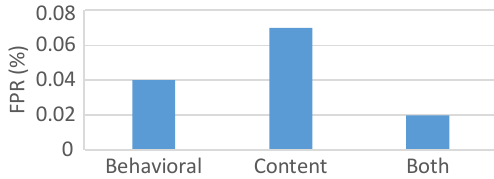
Fig. 10 FPR for ISCX2012 dataset.